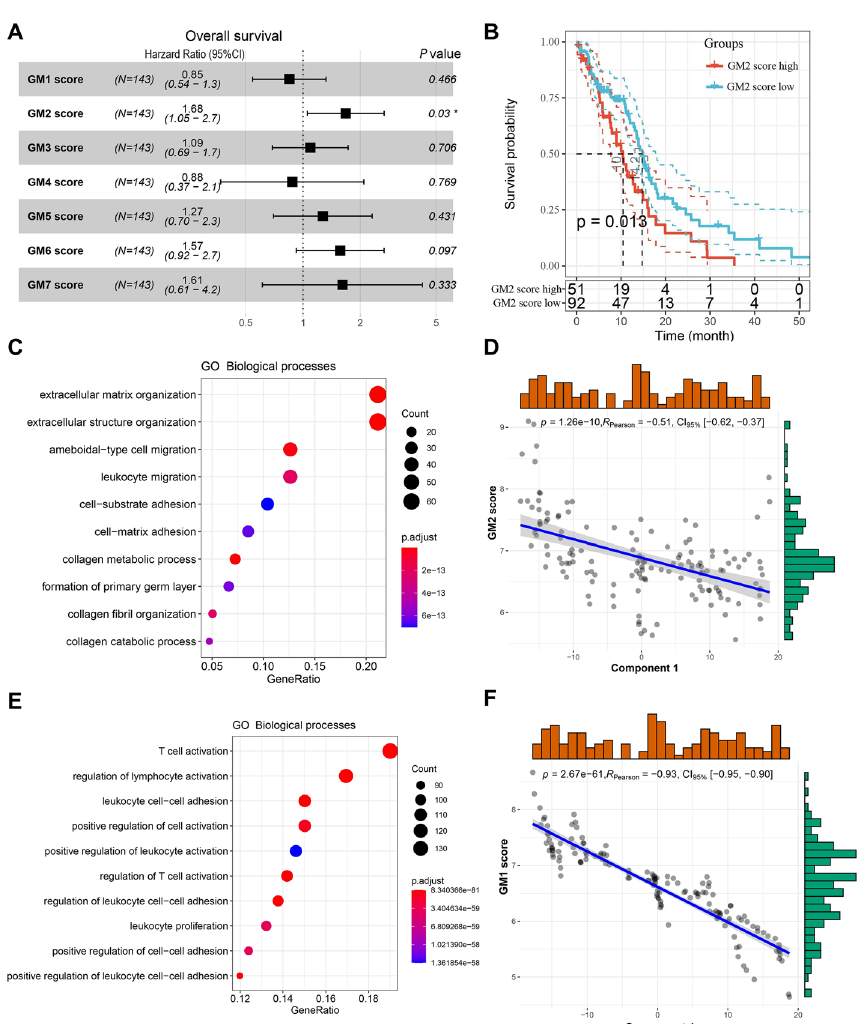
patients. b Kaplan–Meier curve showing OS analysis of GM2 in the TCGA cohort. GO biological process enrichment analysis of GM2 ( c ) and GM1 ( e ). Correlation between GM2 score ( d ) and GM1 score ( f ) and principal component 1 in the immune